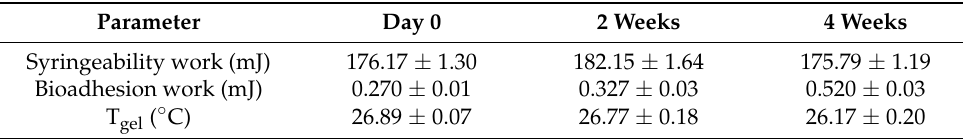
Table 3. Properties of the H-DEMEM-F12 after variable storage time at 4 ◦ C. Data are presented as mean ± SEM.